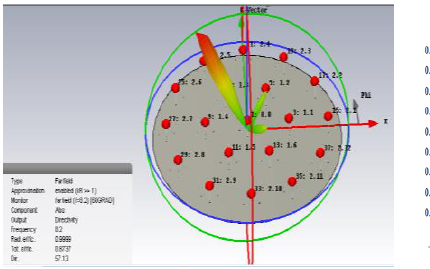
Fig. 8. Dependence of the ellipticity coefficient on the angular coordinates at a frequency f = 8.2